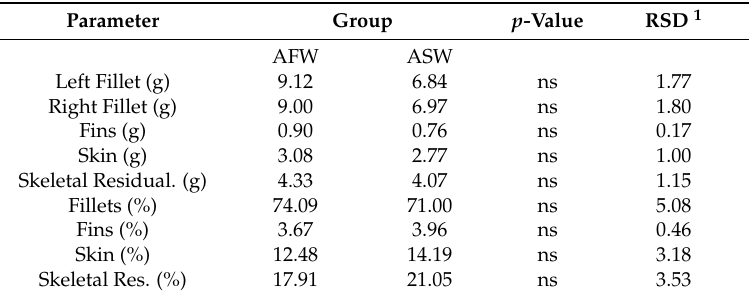
Table 1. Body characteristics of European sea bass reared in AFW and ASW.